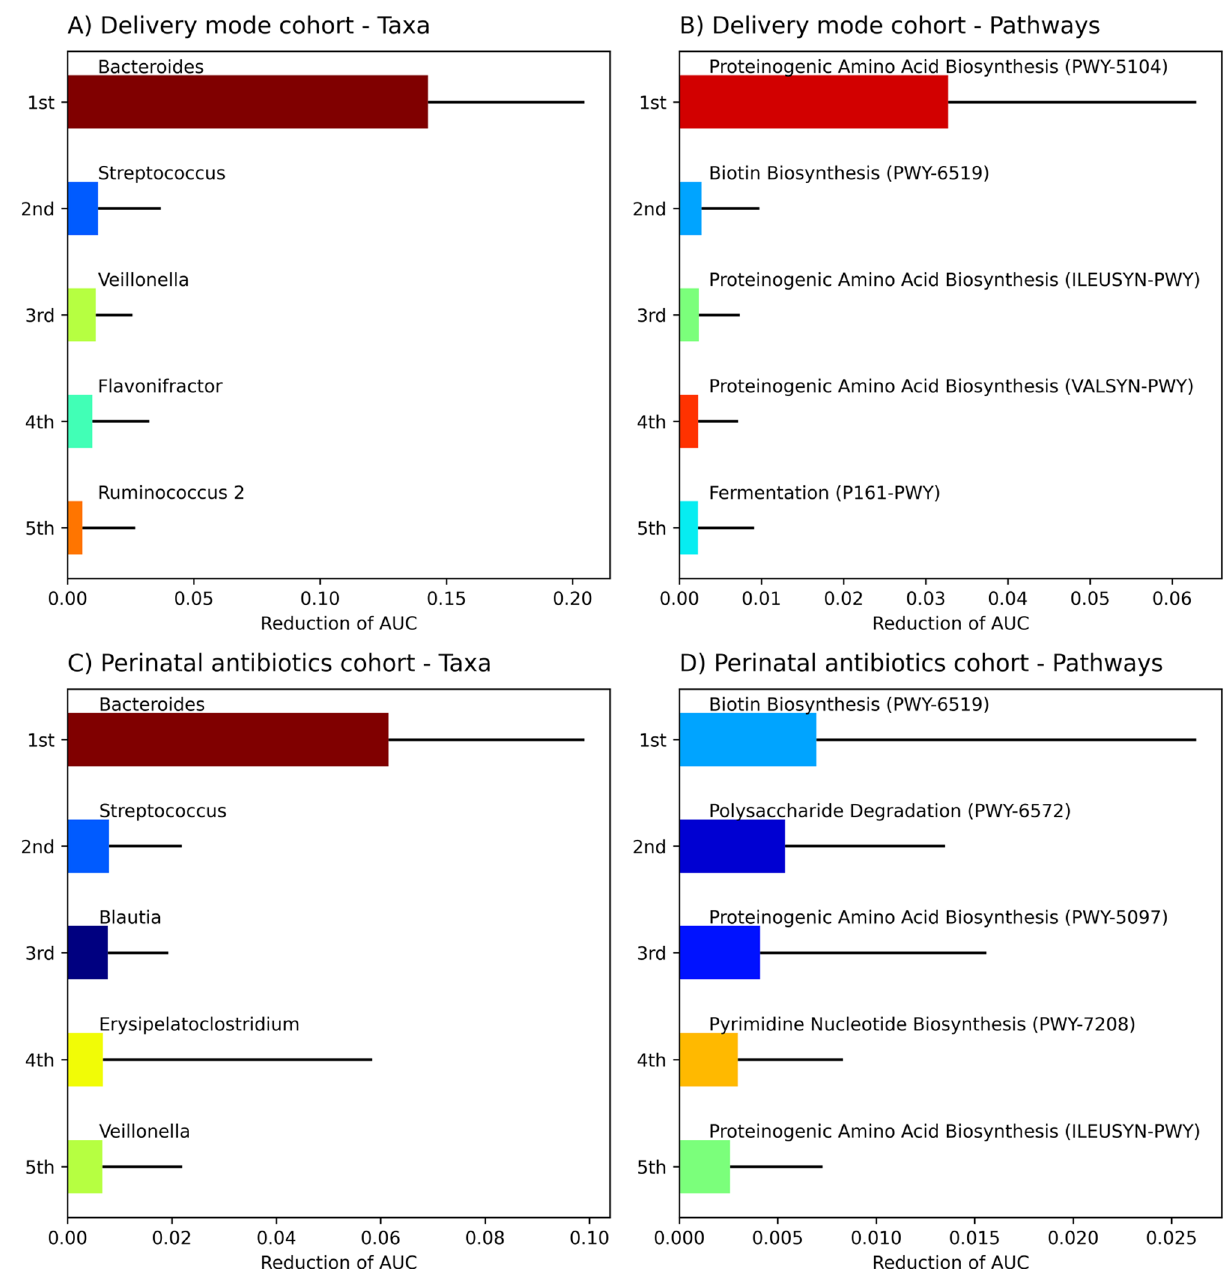
Figure 5. Cross-study importance of taxon and metabolic pathway data for delivery mode ( A and B ) and perinatal antibiotic exposure ( C and D ). Machine learning models were trained on PA cohort ( A and B ) and tested on random DM cohort samples, while models trained using the DM cohort ( C and D ) were tested on random PA cohort samples. The sample labels of each taxon or pathway were permutated one at a time in the test samples, and the changes to AUC were recorded and averaged. Positive error bars are plotted for each feature in